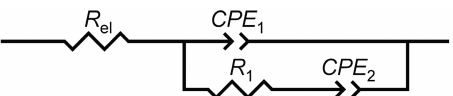
Scheme 1. Equivalent electrical circuit model used for analysis of impedance spectra of electrodes “ACS” and “AC1.8S”.